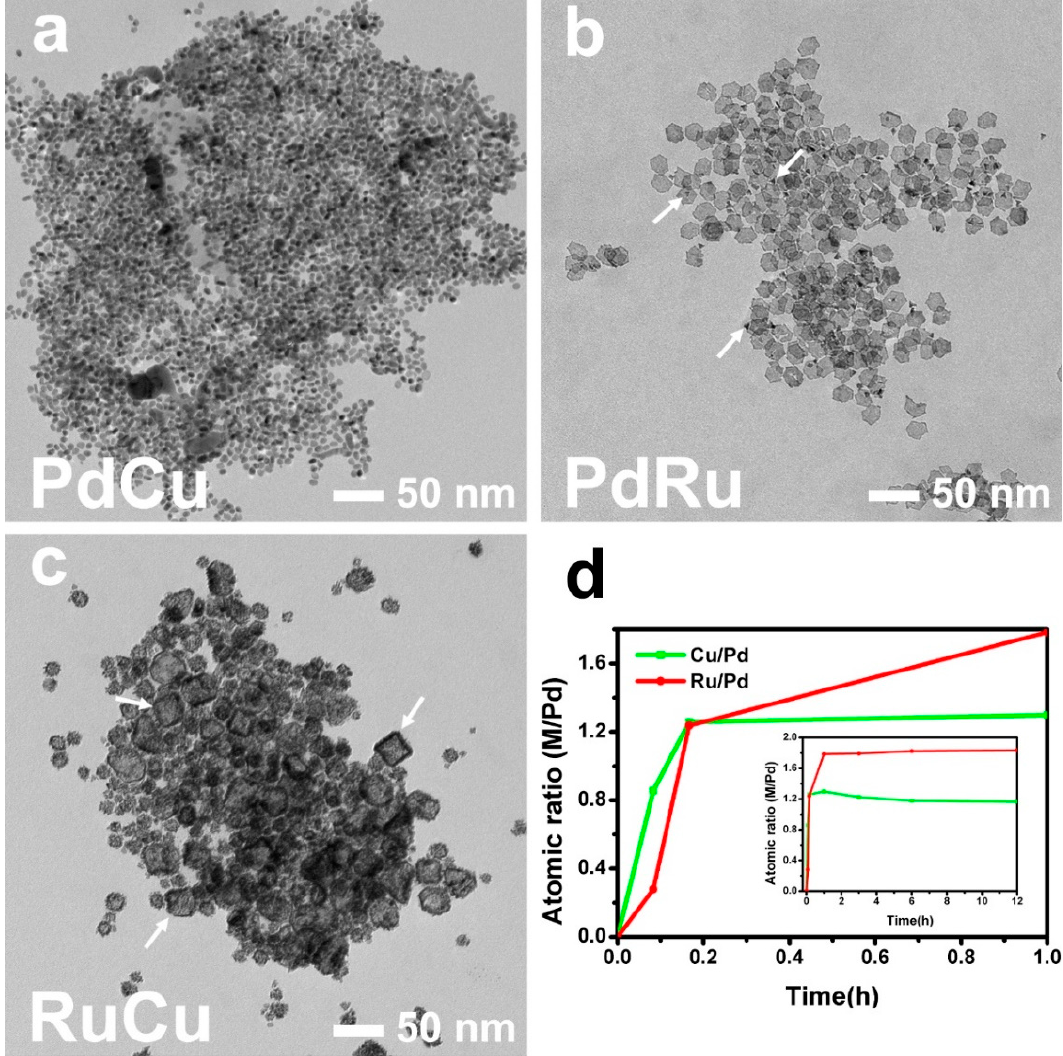
Figure 6. TEM images of the products prepared using the standard procedure, except for ( a ) in the absence of Ru precursor, ( b ) in the absence of Cu precursor, ( c ) in the absence of Pd seeds. ( d ) The variation in the atomic ratio of Cu and Ru to Pd for the Pd 24 Cu 29 Ru 47 nanoplates at different reaction time measured by ICP-AES technique.